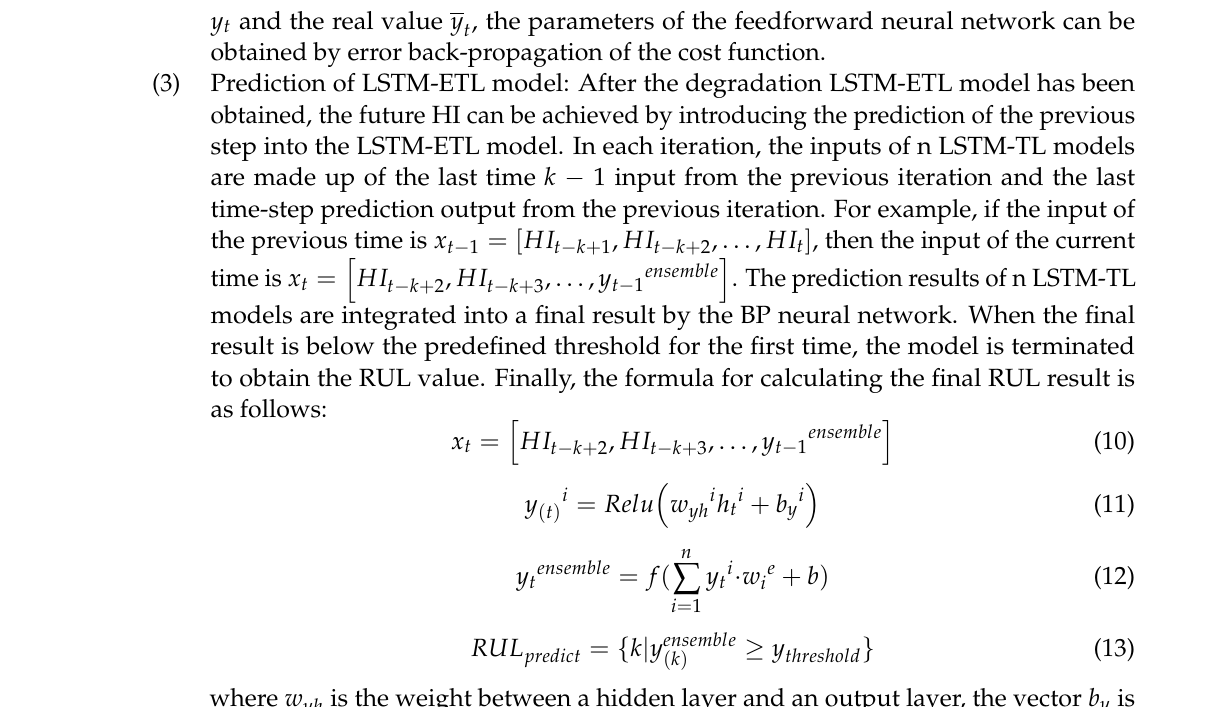
Figure 6. Construction of the proposed LSTM-ETL mode.